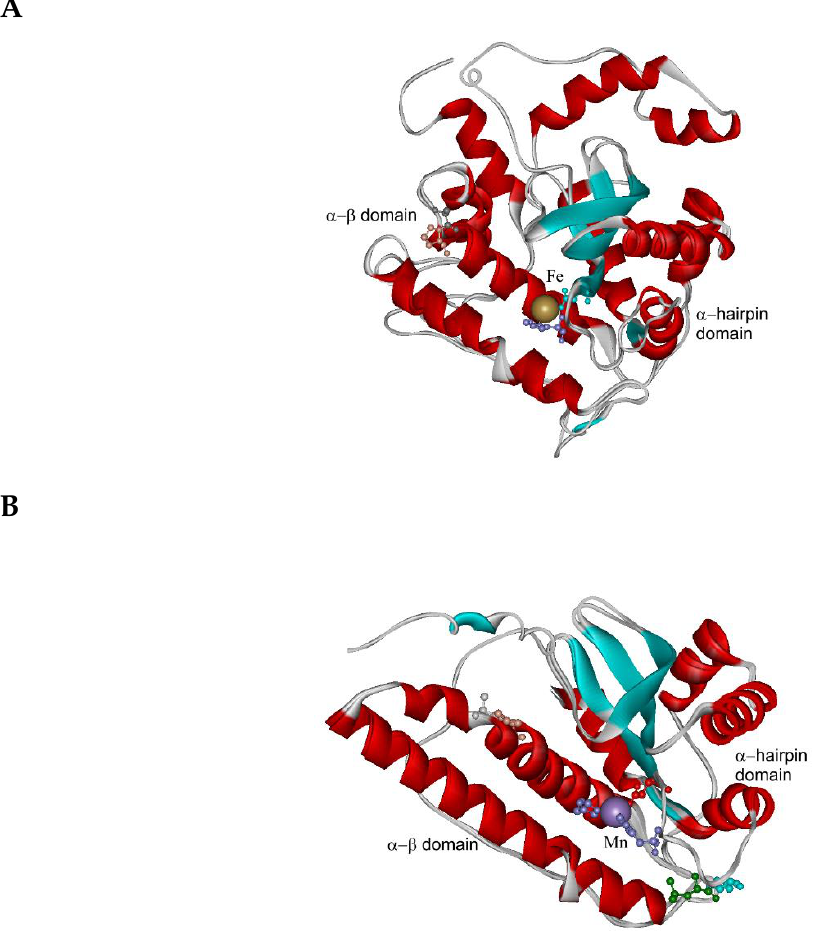
Figure 5. Structural models for members of the Fe-MnSOD family from Chaetomium thermophilum var. dissitum modeled with Phyre-2 server [16]. ( A ) FeSOD modeled on the structure of 4h3e from Trypanosoma cruzi , presented in Figure 4 as TcruFeSOD and ( B ) MnSOD1 modeled on the structure of 4br6 from Chaetomium thermophilum var. thermophilum presented in Figure 4 as CtheMnSOD. 3.3. Catalases (CAT, EC